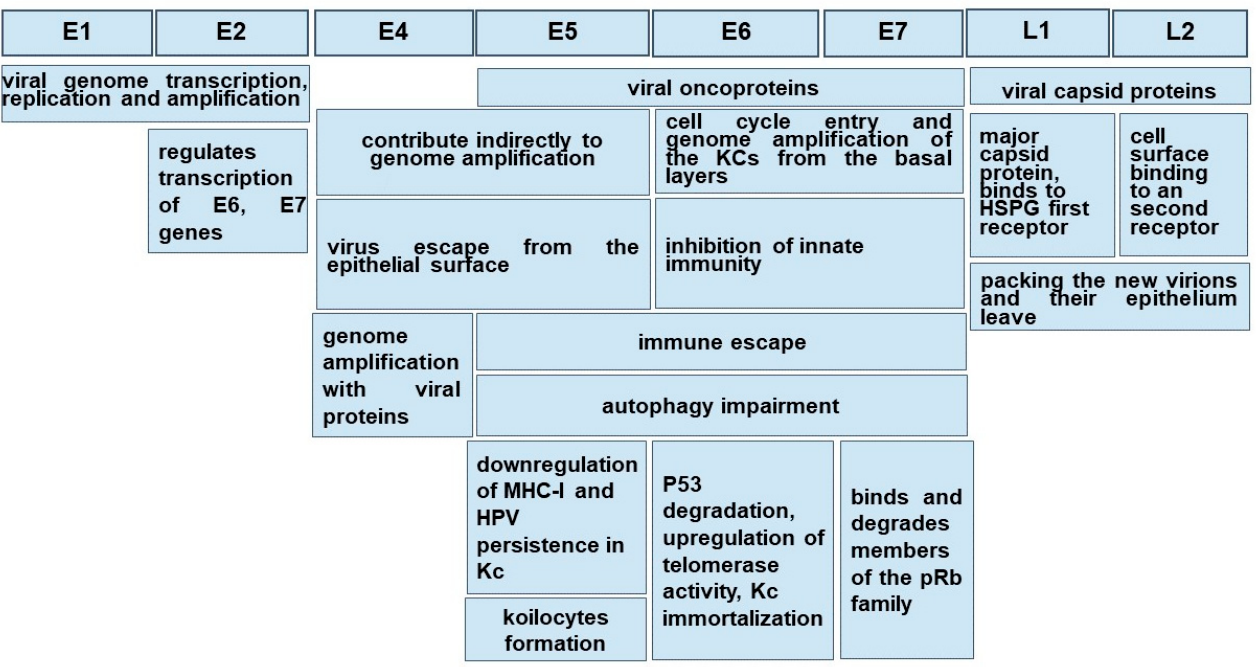
Figure 2. The roles of high-risk HPV main gene products. E1-L2—HPV genes; Kc-Keratinocyte; HSPGs—heparan sulfate proteoglycans